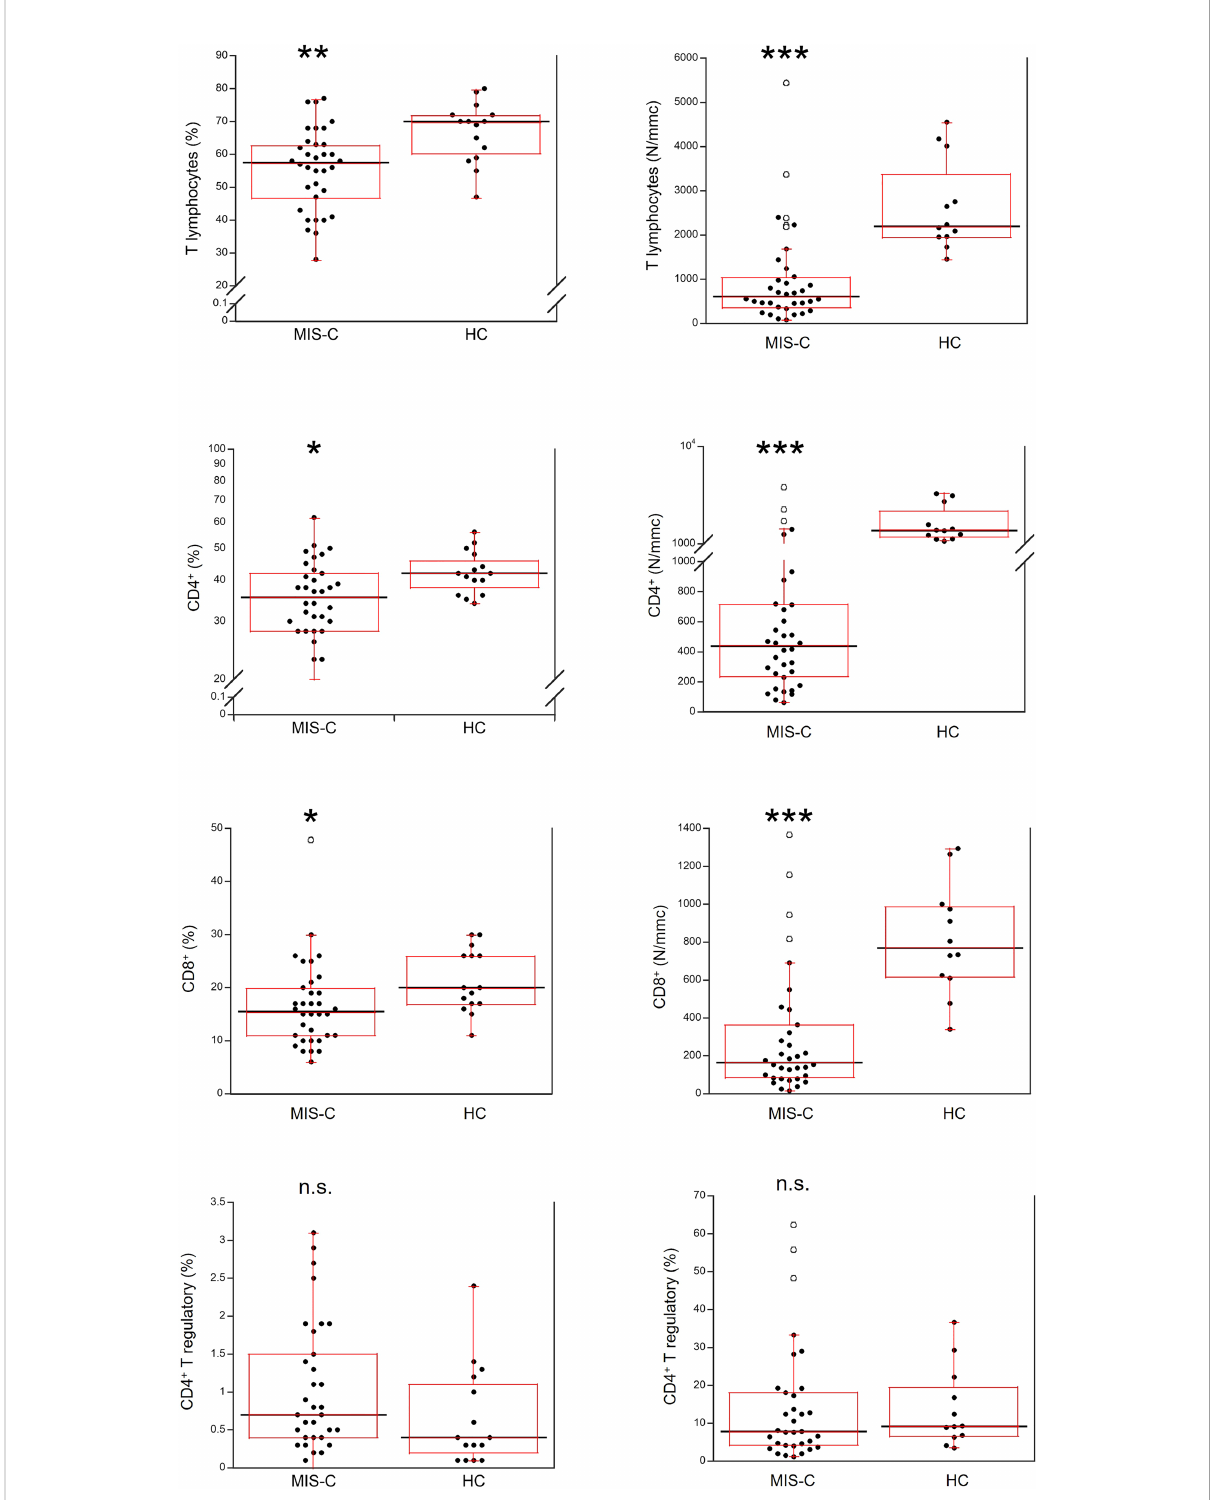
FIGURE 4 Comparison of total T lymphocytes and T lymphocyte populations in 37 patients with MIS-C and in 24 HC. The black line represents the median value. The red box represents the interquartile range. The blank circles correspond to the outliers and the black circles side by side to these correspond to duplicates *p < 0.01; **p < 0.001; ***p < 0.0001; n.s.: not signi fi cant (p >